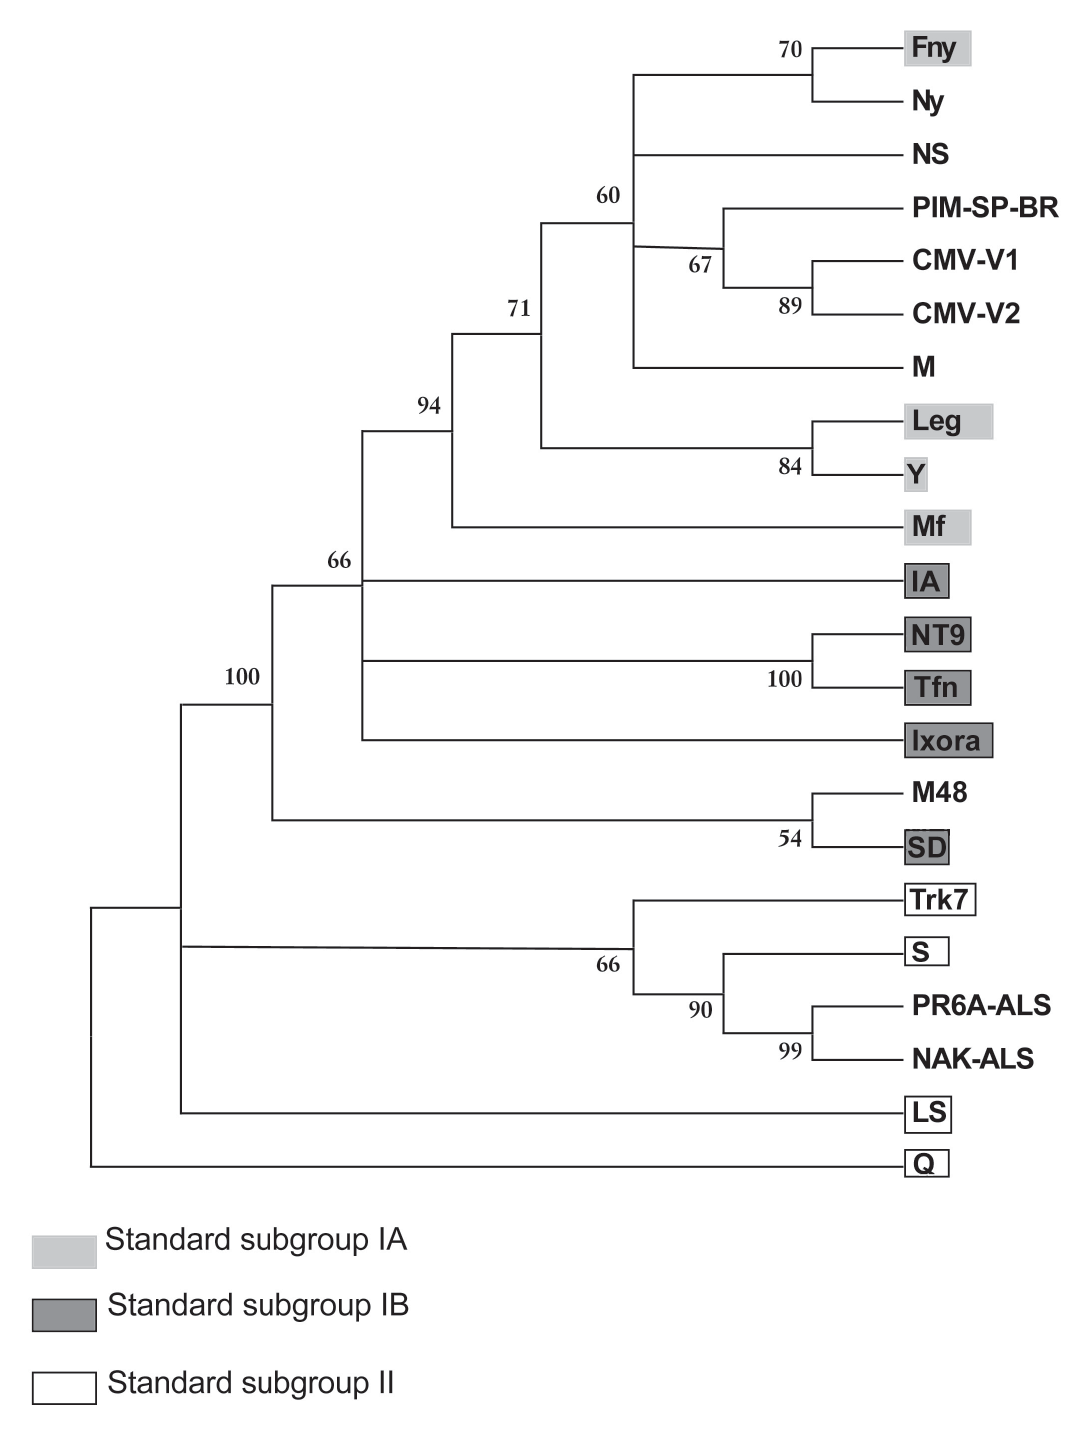
Fig. 2. Bootstrap consensus trees of coat protein (CP) of RNA3 from CMV-1 and CMV-2 partial sequences, construct- ed with the MEGA program according to the neighbour-joining method. Bootstrap values (percentage) are indicated in the nodes, strain acronyms are as in the